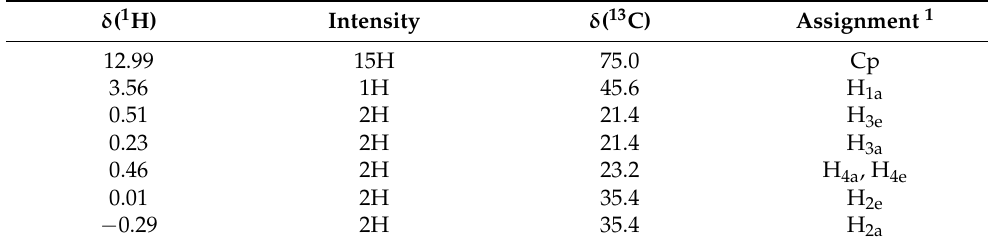
Figure 4. 2D CH correlation NMR spectrum of (Cp) 3 Pu(C ≡ NCy) measured in C 6 D 6 , including all detectable cross peaks. Inset is the magnification of the marked zone. The peak marked with a * arises from decomposition of the sample. Table 2. Assignment of the 1 H and 13 C NMR resonance signals (ppm) of (Cp) 3 Pu(C ≡ NCy).